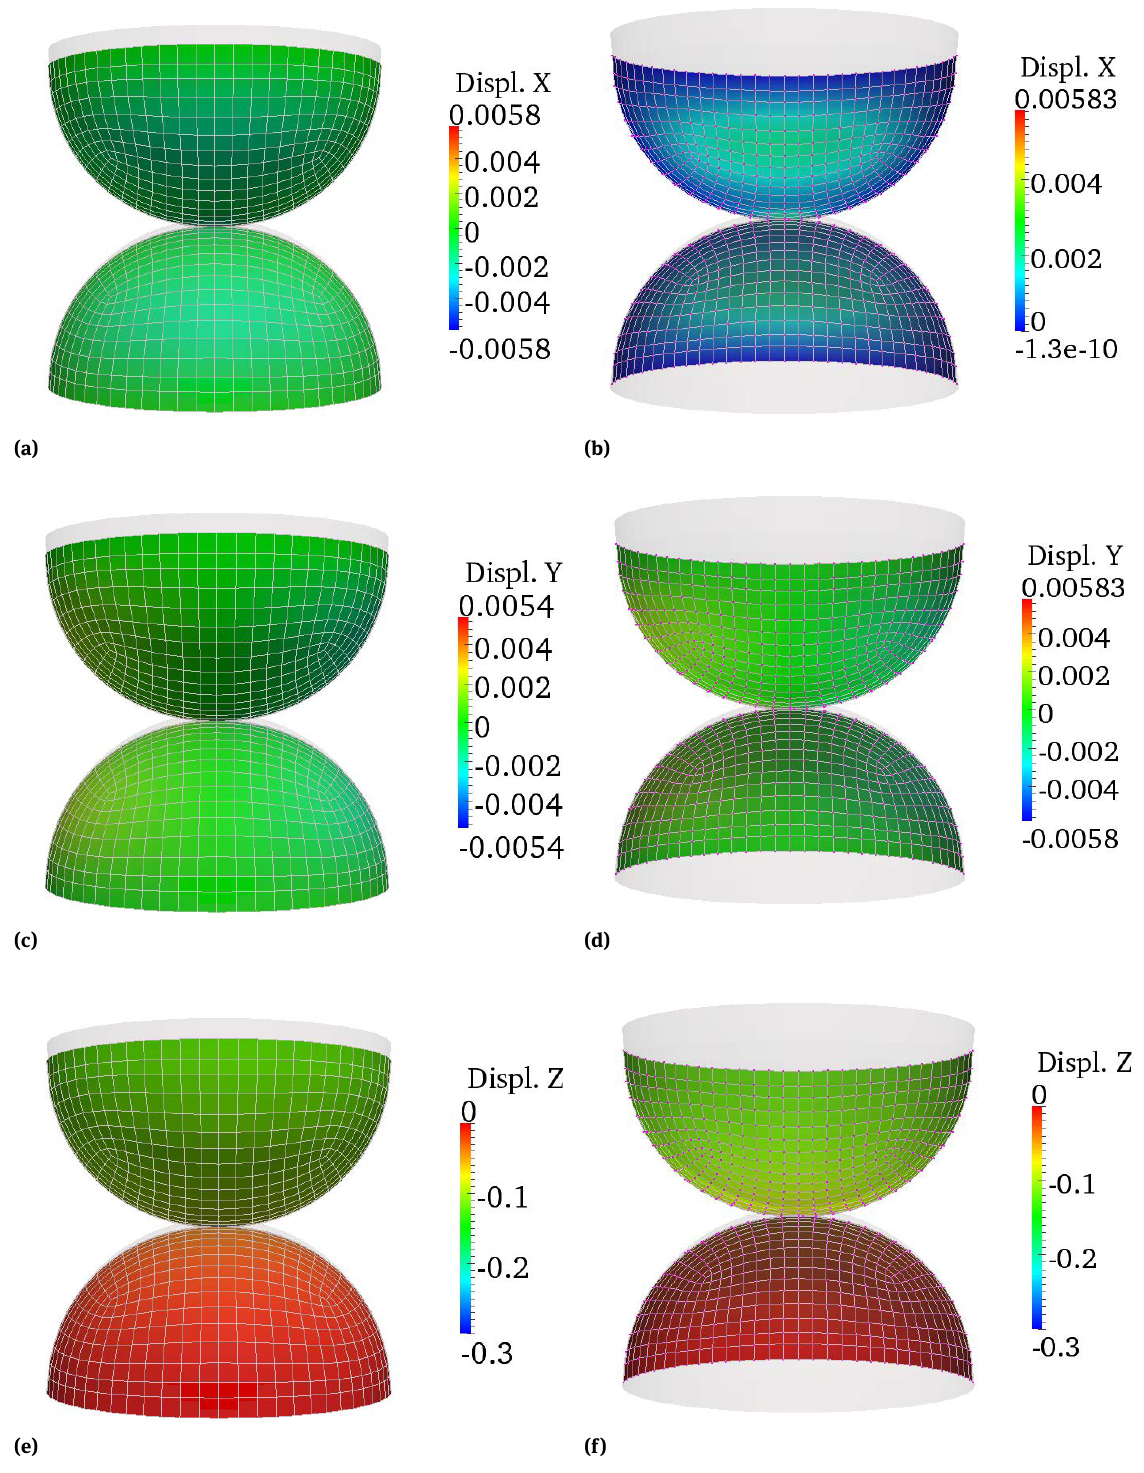
Figure 15: Hemispheres in normal contact: undeformed and deformed shape and displacement contours for step